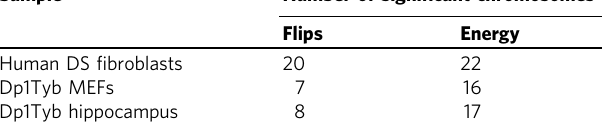
Table shows the numbers of chromosomes that had signi fi cantly (>2SD) reduced numbers of fl ips or increased energy in comparisons of changes in gene expression in human DS vs euploid